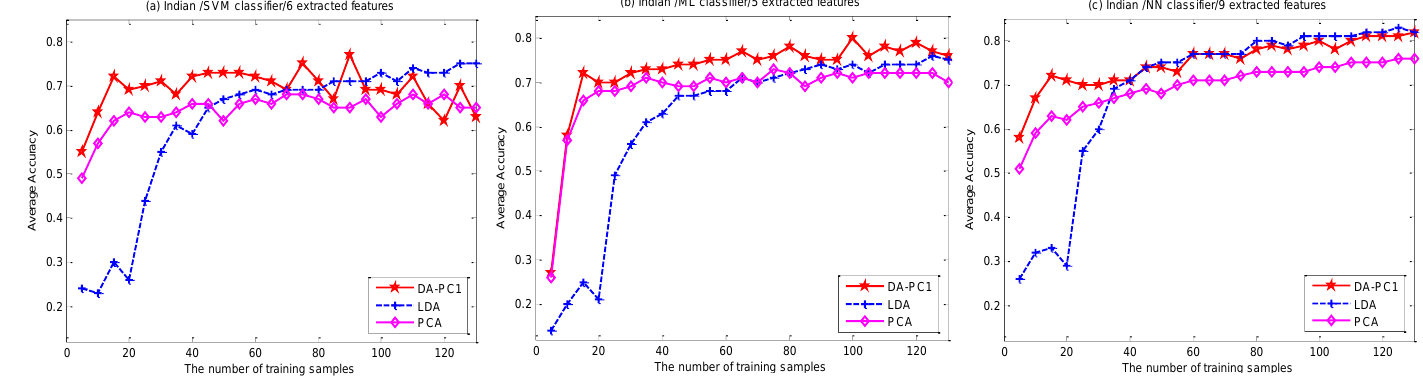
Figure 5. The comparison of performance of DA-PC1 with PCA and LDA in a fixed number of extracted features with varying the number of training samples for Indian dataset with a) SVM classifier and 6 extracted features, b) ML classifier and 5 extracted features, c) NN classifier and 9 extracted